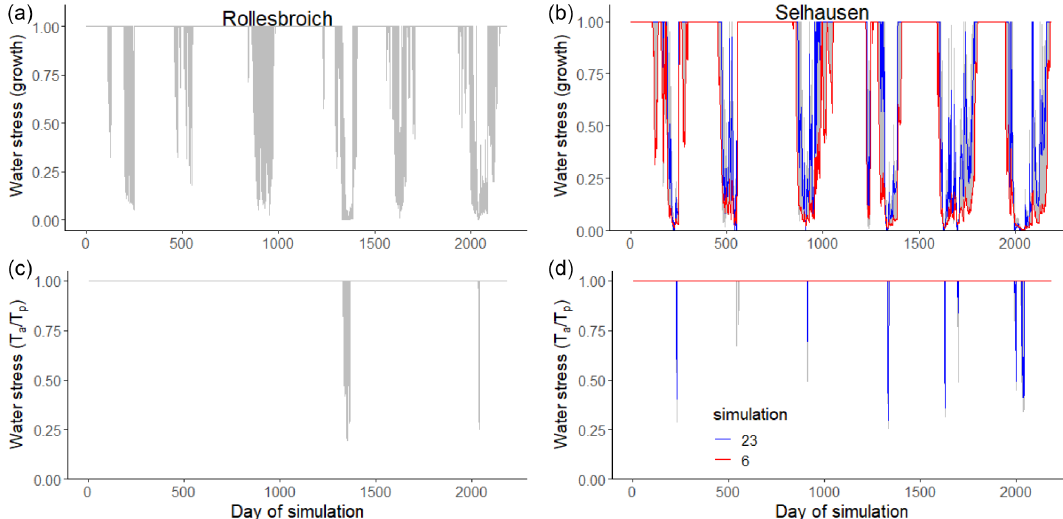
Figure 8. Plots of the two water stress functions in the model for the acceptable simulations. The uppermost figures show the threshold function of the pressure head at the root surface (Eq. 35) controlling dry-matter allocation and leaf loss, while the figures at the bottom show the ratio of actual to potential transpiration, which controls assimilation (Eq. 34). Two contrasting acceptable simulations for the Selhausen site are highlighted in red and blue. Day 1 is 1 January 2013.